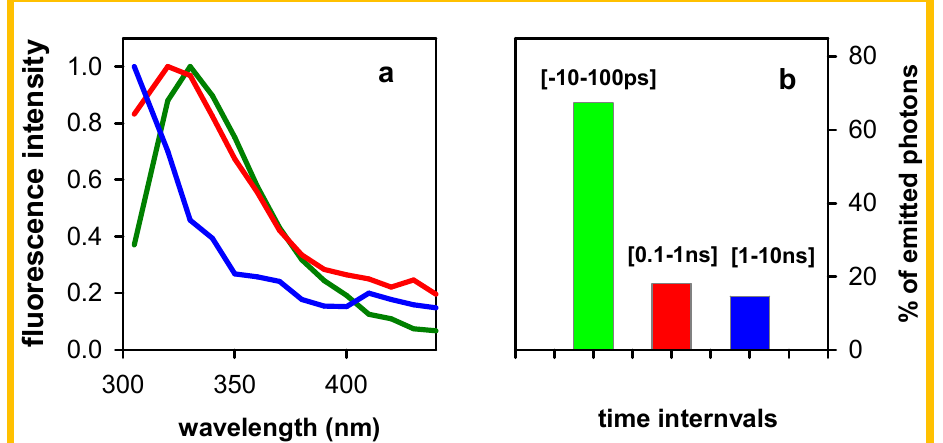
Figure 2. Spectral and temporal distribution of the photons emitted by of pA • pT following 267 nm excitation: ( a ) spectra (305–440 nm) integrated over the time-windows [ − 50–50 ps] (green), [0.1–1 ns] (red) and [1–10 ns] (blue) and normalized at their maximum; ( b ) percentage of the total number of photons emitted at successive time intervals on the 305–440 nm range.